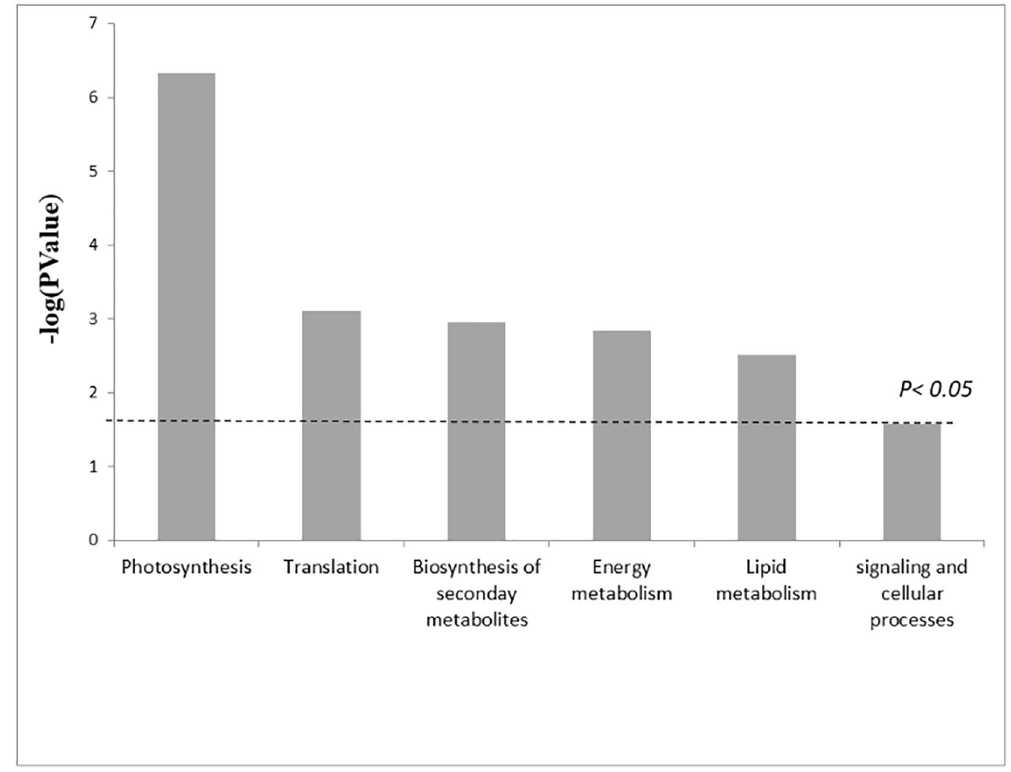
Figure 4. KEGG pathways where the differentially abundant proteins were enriched. The x-axis shows the proteins involved in the extended KEGG network and pathways. P values were calculated using a modified Fisher’s exact test. Values above the threshold indicate p < 0.05. KEGG pathways are developed by Kanehisa Laboratories 32